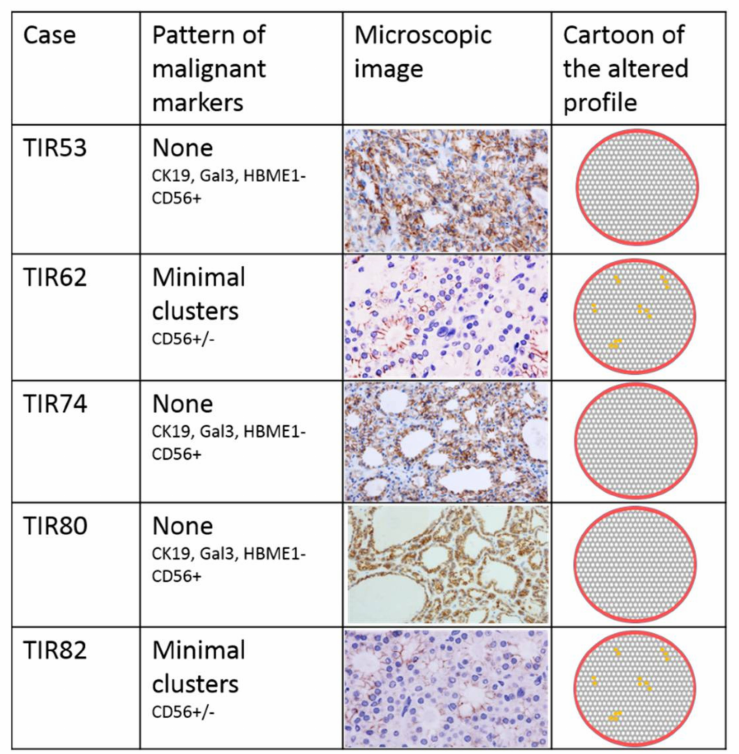
Figure 3. Five cases that dropped in the benign Raman clusters: none of them show expression of proteins acquired during neoplastic transformation; two out of five show minimal loss of CD56 (see microscopic images) (+ positive reaction; - negative reaction). The cartoons on the right-hand panels model different patterns of markers